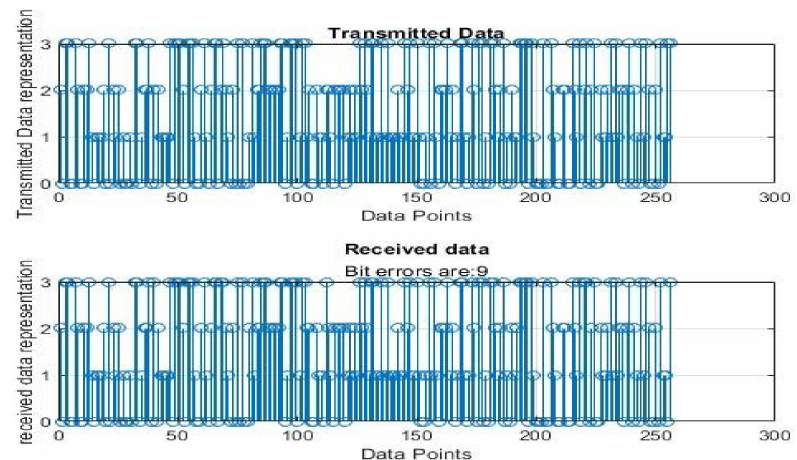
Figure 12. GAWDO QPSK output for 256 data points in a noisy channel.